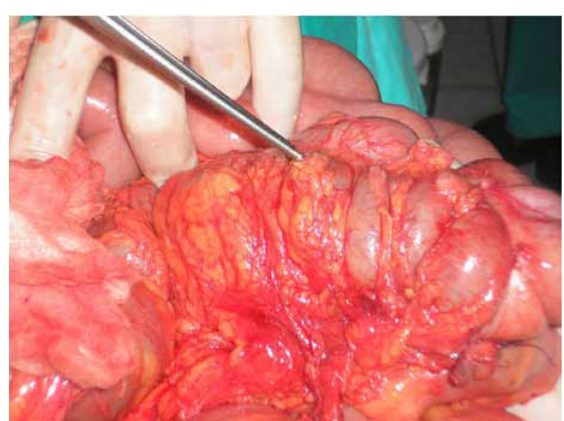
Figure 1. Intraoperative view of multiple, large bleeding diverticula of the colon.